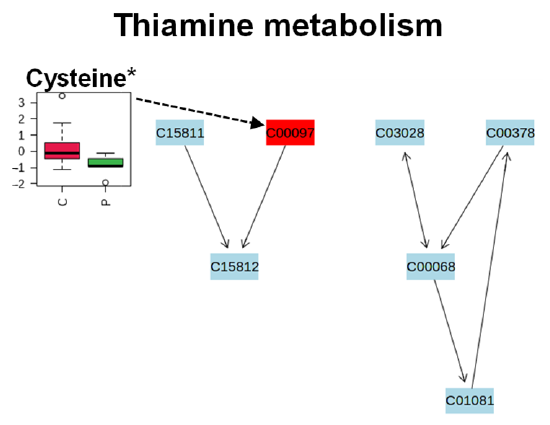
Figure A3. Detailed results of the pathway analysis in Figure 4b. Nodes with mapped data are colored. In each box plot, C and P indicate the data without and with depressive episodes, respectively. * p < 0.05.